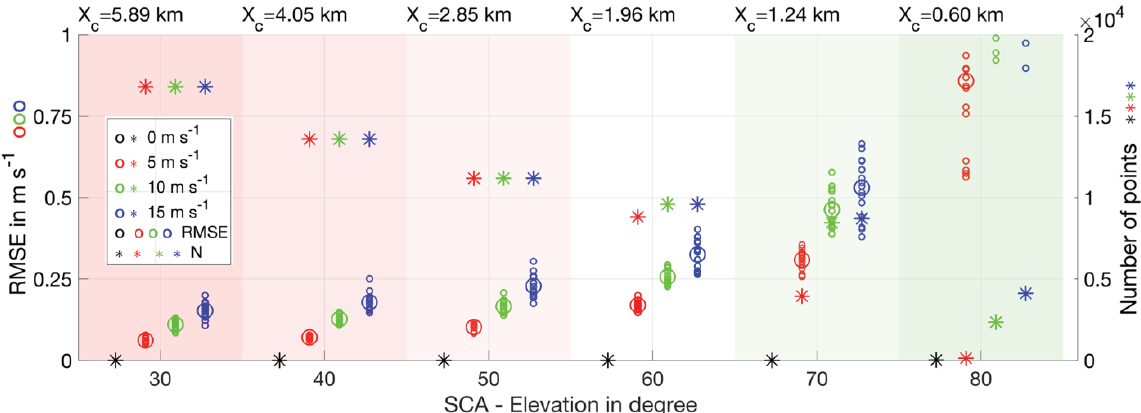
Figure 3: Root-mean-squared error (RMSE) and number of retrieved profiles for varying scan elevation angles and different background wind cases. All other parameters according to Tab. 1. For the 0 m s -1 background wind speed case no retrievals pass quality